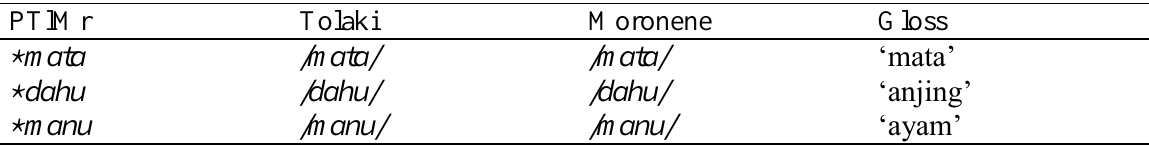
Table 2. The Middle Position